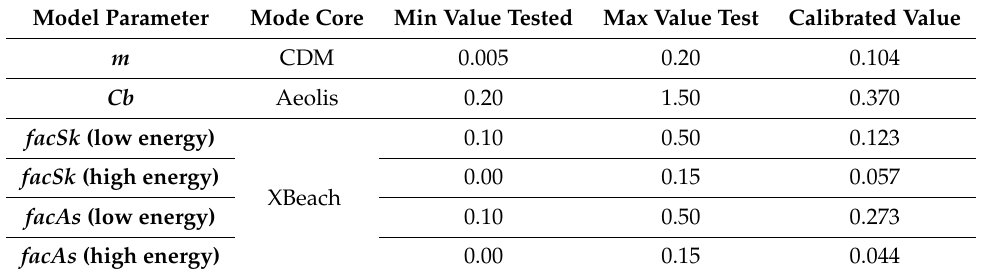
Listing of range of values tested and optimum parameter settings based on the calibration